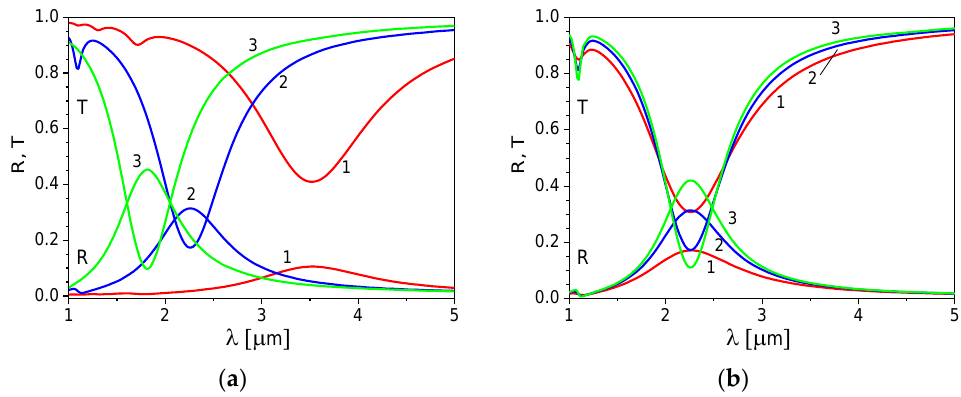
Figure 4. Influence of the 2D electron concentration ( a ) and the electron relaxation time ( b ) on the reflection and transmission spectra of the ITO nanoribbon grating: ( a ) n 2 D = 2 × 10 19 m − 2 —curves 1, 5 × 10 19 m − 2 —curves 2, 8 × 10 19 m − 2 —curves 3, and τ = 7 fs ; ( b ) τ = 4 fs —curves 1, 7 fs —curves 2, and 10 fs —curves 3; n 2 D = 5 × 10 19 m − 2 ; and grating spacing Λ = 500 nm, aspect ratio d / Λ = 0.5, and director angle ψ = π/2.